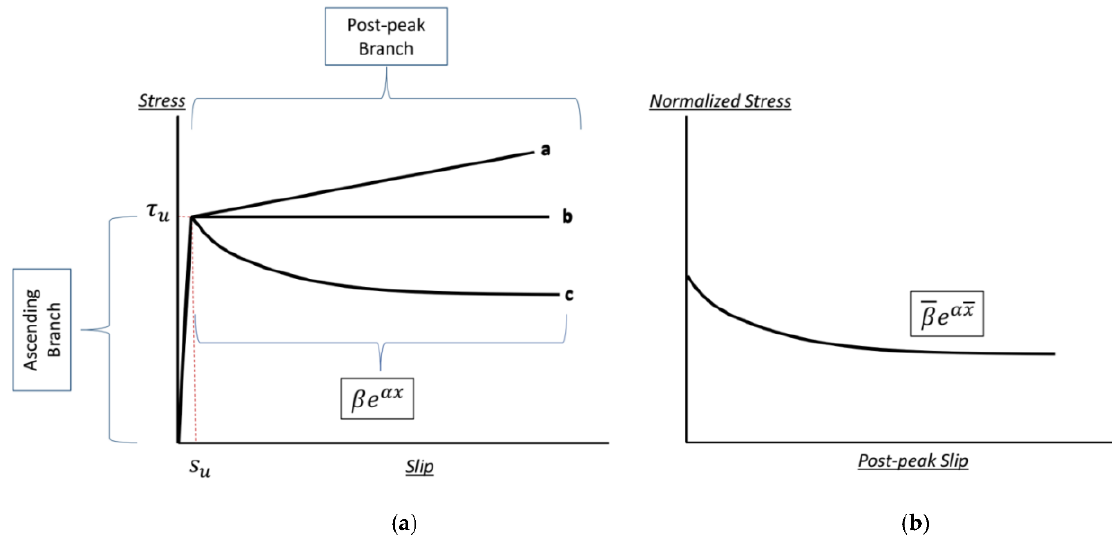
Figure 1. Idealized response curves of concrete-filled steel tubes (CFSTs) under push-out loading test to represent; ( a ) the overall behavior and ( b ) the normalized post-peak behaviour.